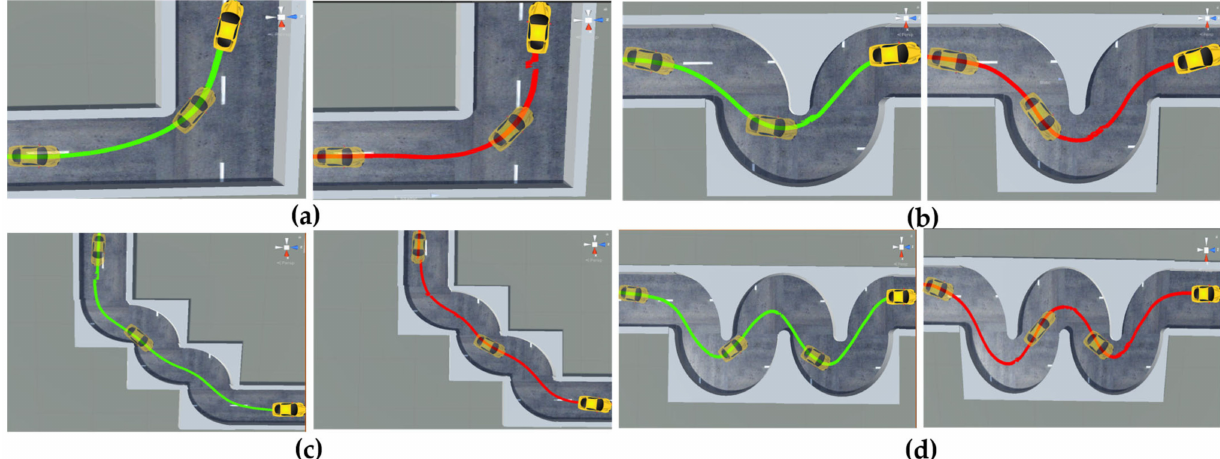
Figure 16. The actual effect of virtual car autonomous driving in different road conditions. ( a ) is an “L”-shaped road condition, ( b ) is a “U”-shaped road condition, ( c ) is an “S”-shaped road condition, and ( d ) is a “W”-shaped road condition.